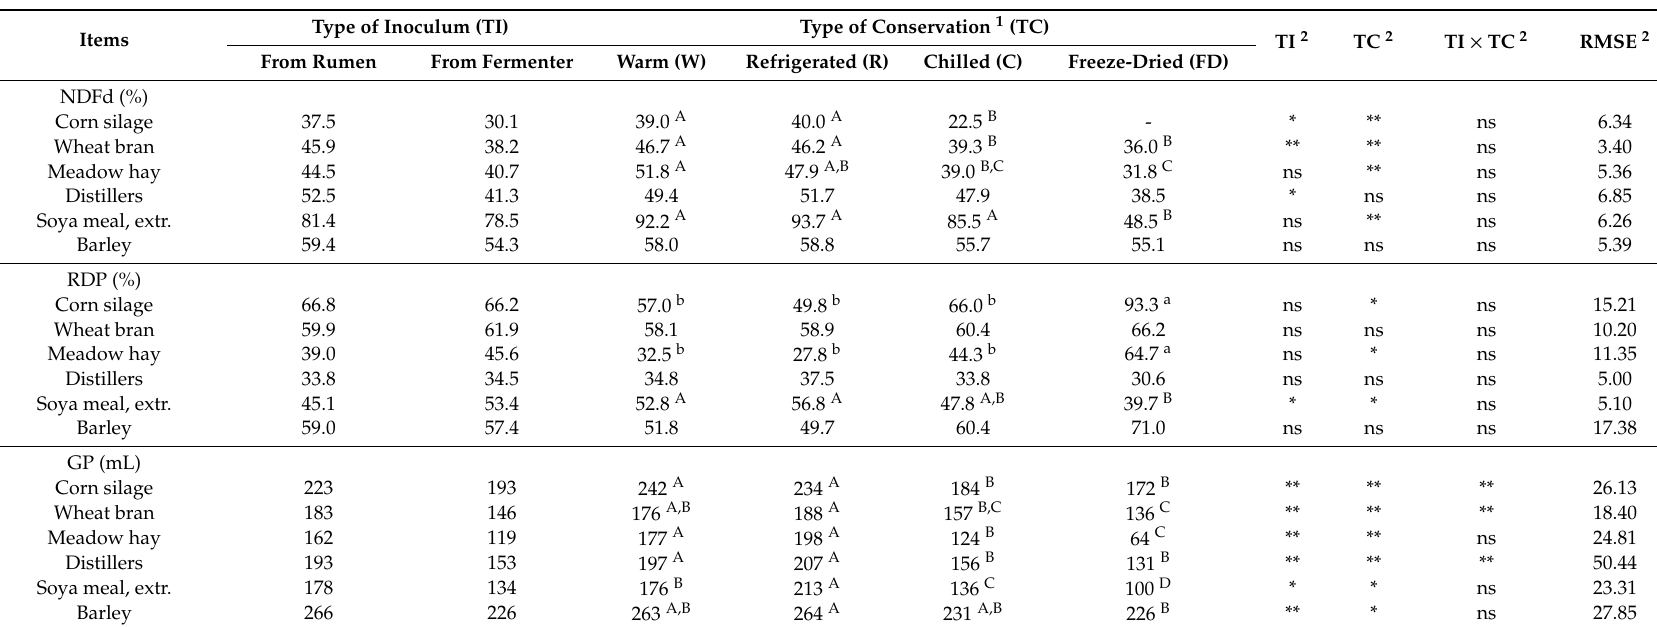
Table 3. In vitro degradability of NDF (NDFd), CP (RDP), and gas production (at 24 h of fermentation, GP) of six substrates using rumen inoculum di ff ering for origin and for conservation